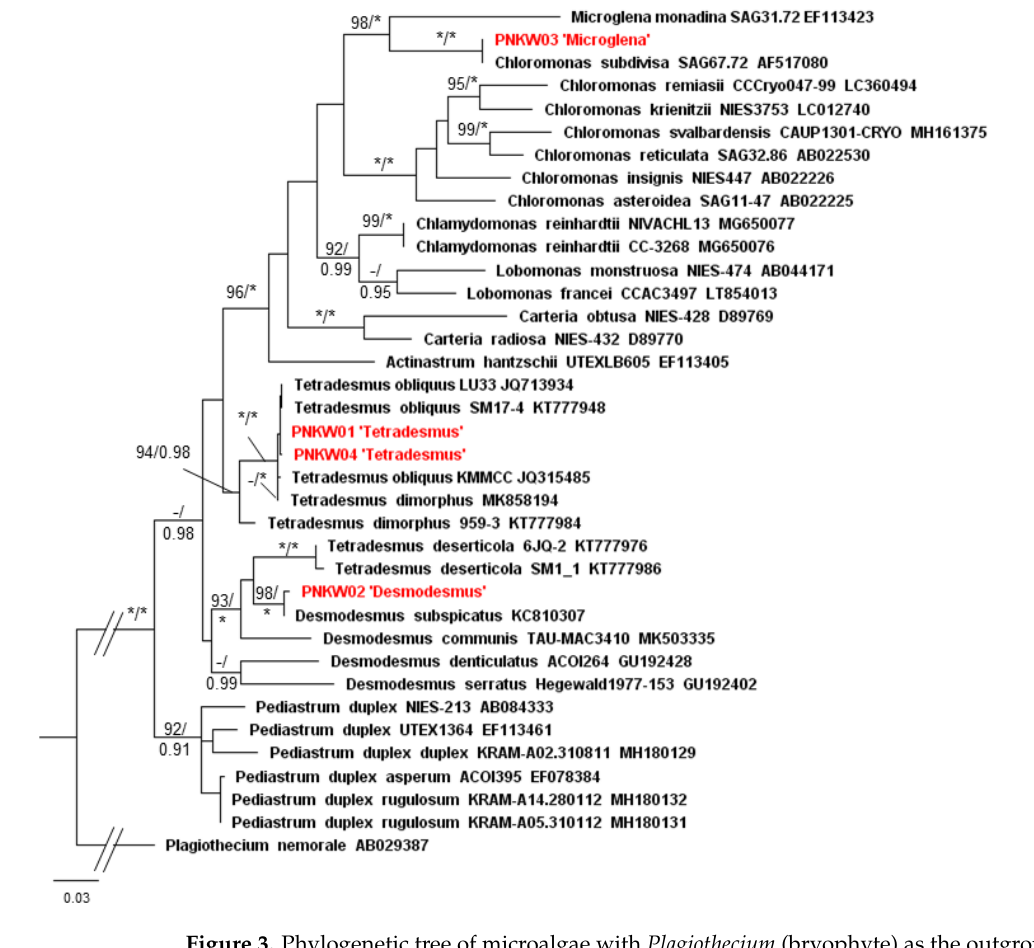
Figure 3. Phylogenetic tree of microalgae with Plagiothecium (bryophyte) as the outgroup taxa based on the rbcL marker (total 698 bp). The tree shows the position of the studied strains among the green microalgae. Numbers on the branches indicate bootstrap values from ML followed by posterior probabilities from BI analysis. Asterisk (*) indicates 100 (ML) and 1.00 (BI) values, while negative values (−) indicate values below 90 (ML) and 0.90 (BI). Names of taxa were verified according to the recent taxonomic changes with the use of the AlgaeBase database [17]. The topology of the tree was based on the ML analysis.